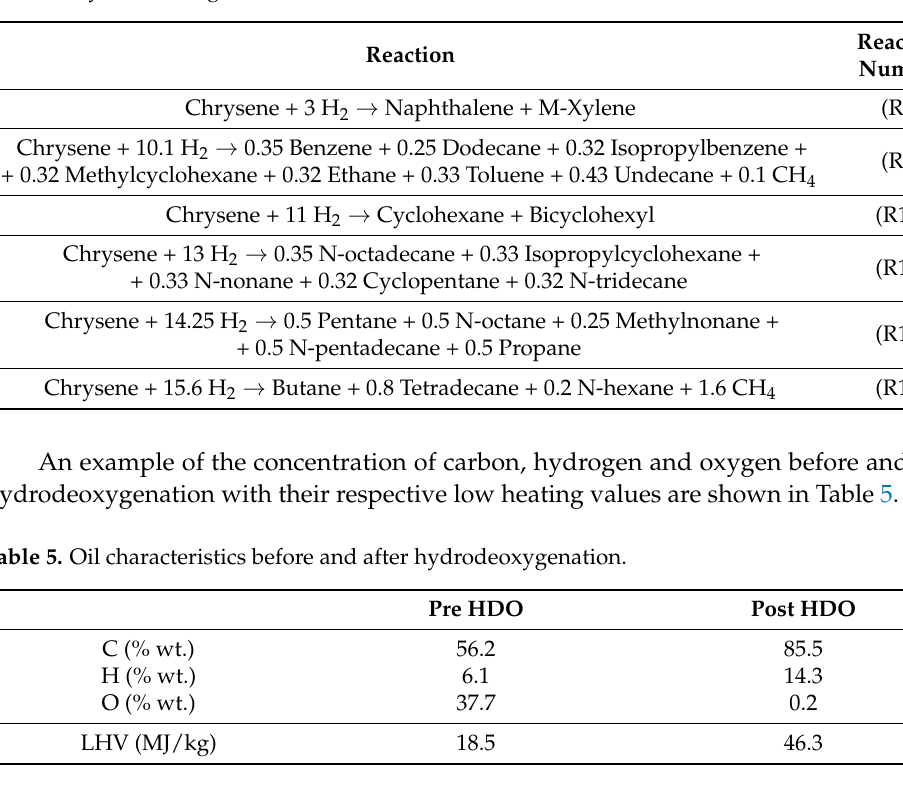
Table 4. Hydrocracking reactions.